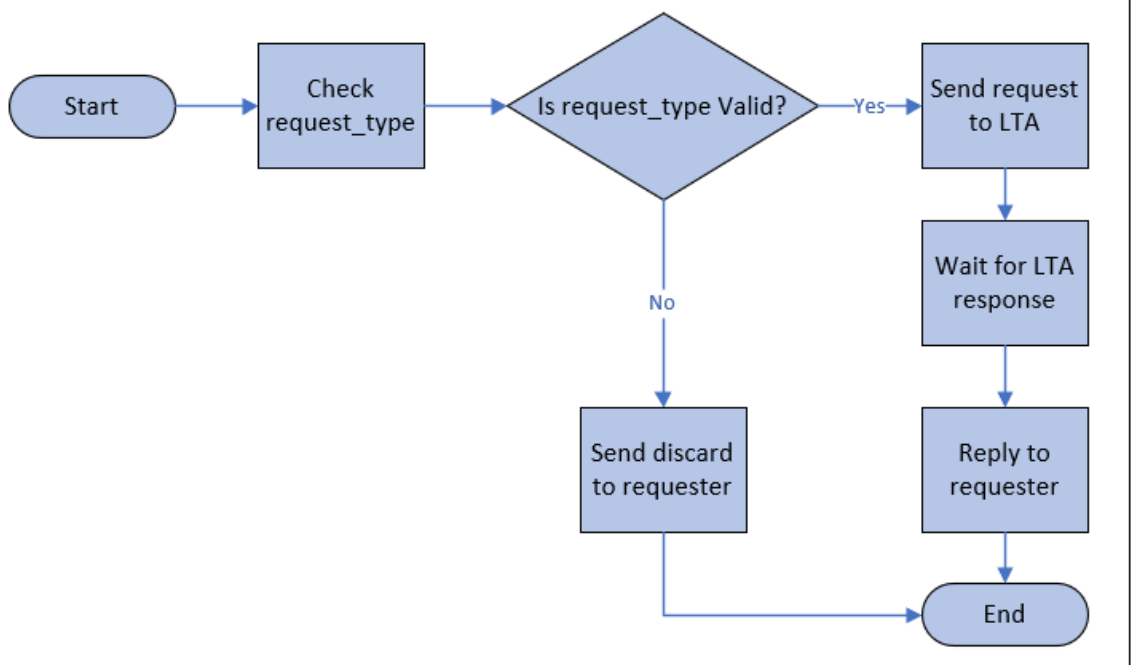
Figure 7. Operation flowchart of Request processor.